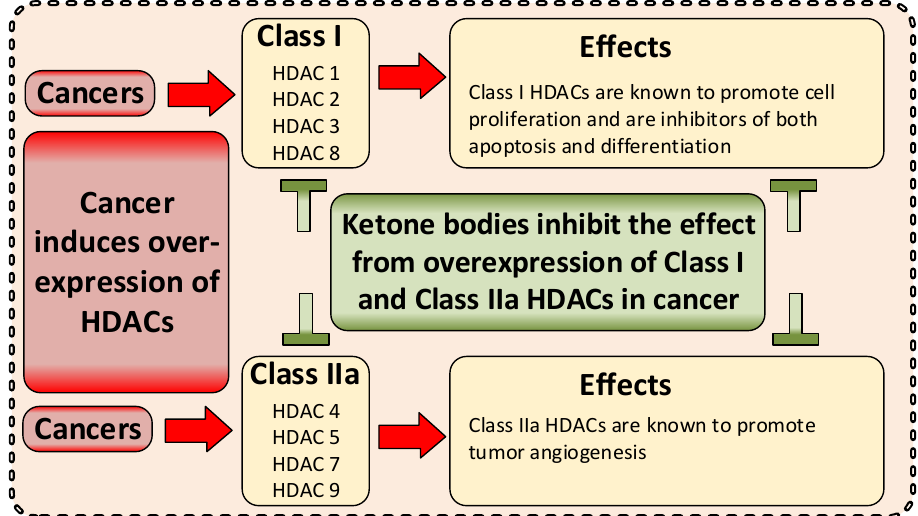
Figure 9. Elevated HDACs are linked to oncogenesis and HDACs have pleiotropic effects and promote many oncogenes. Reducing HDACs through HDAC inhibitors can improve therapeutic efficacy of TCTs. For example, the strong suppression of apoptosis seen in many cancer cells will be reduced through the inhibition effects that KBs are shown to induce at physiological levels [6,40,120,121,128,129].